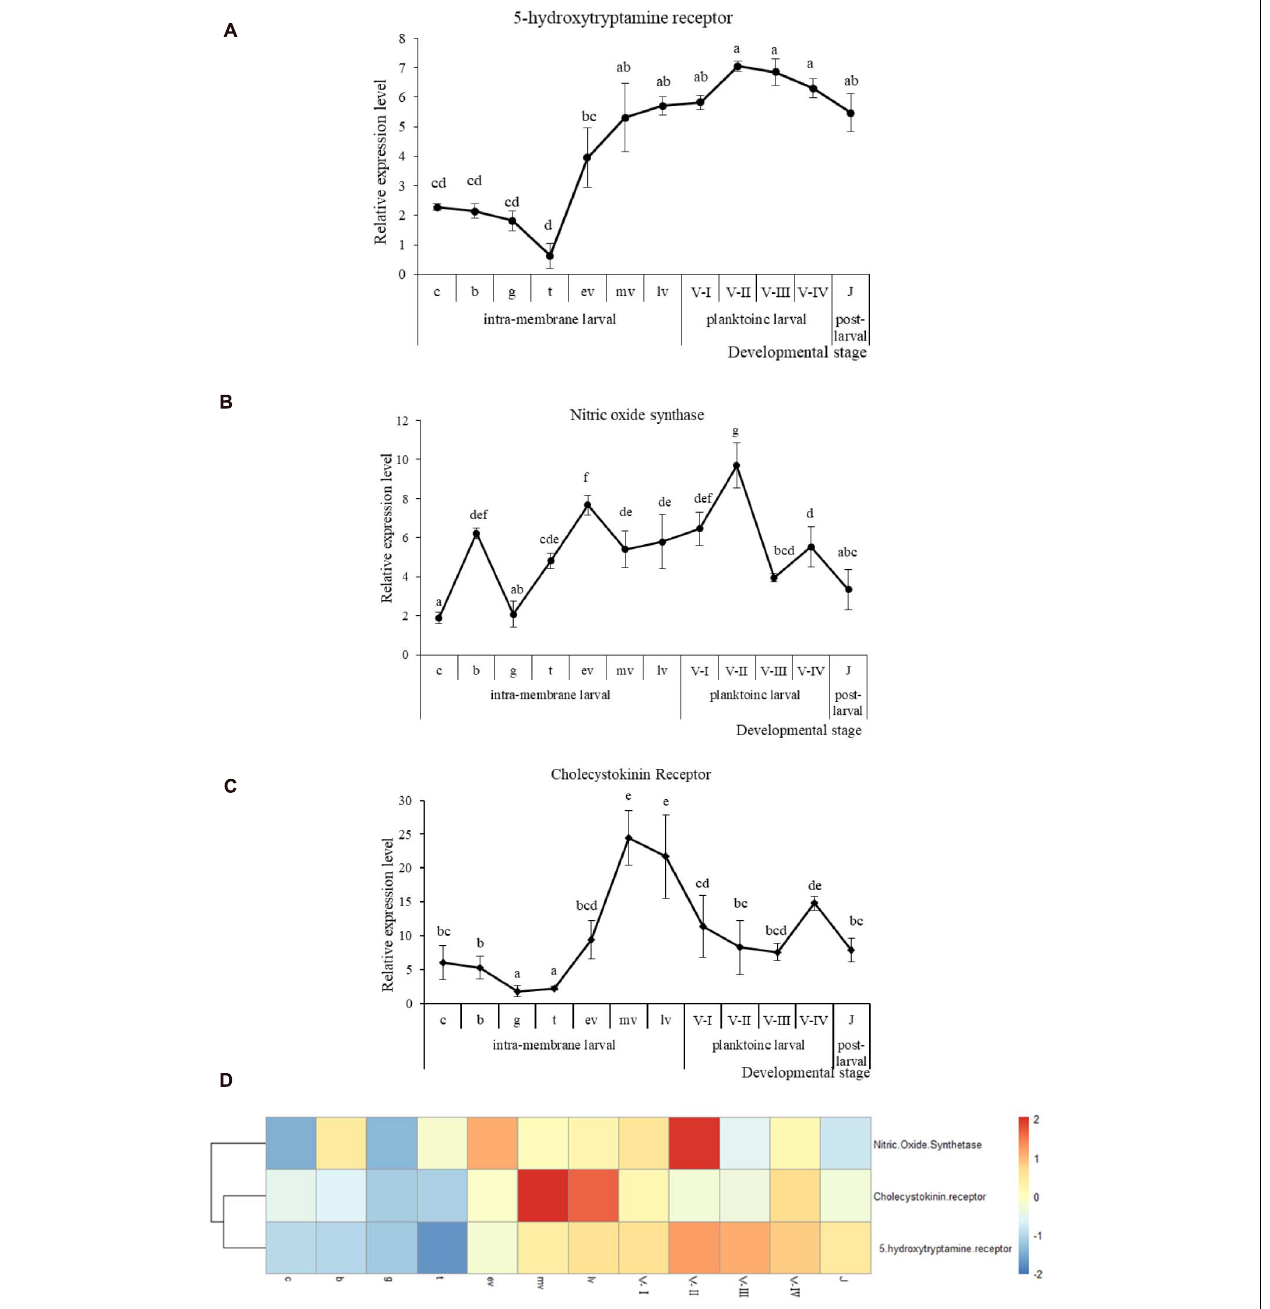
FIGURE 3 | qRT-PCR analysis of Rv-5HTR (A) , Rv-NOS (B) , and Rv-CCKR (C) mRNA expression and the heatmap (D) of three genes expression during Rapana venosa larval development (mean ± SEM, n = 3). Different superscript letters indicate significant differences ( P < 0.05). [the cleavage stage (c), the blastula stage (b), the gastrulae stage (g), the trochophore stage (t), the early intramembrane veliger stage (ev), the middle intramembrane veliger stage (mv), and the later intramembrane veliger stage (lv). the one-spiral whorl stage (V-I), the two-spiral whorl stage (V-II), the three-spiral whorl stage (V-III), the four-spiral whorl stage (competent larva, V-IV), and the postlarval stage